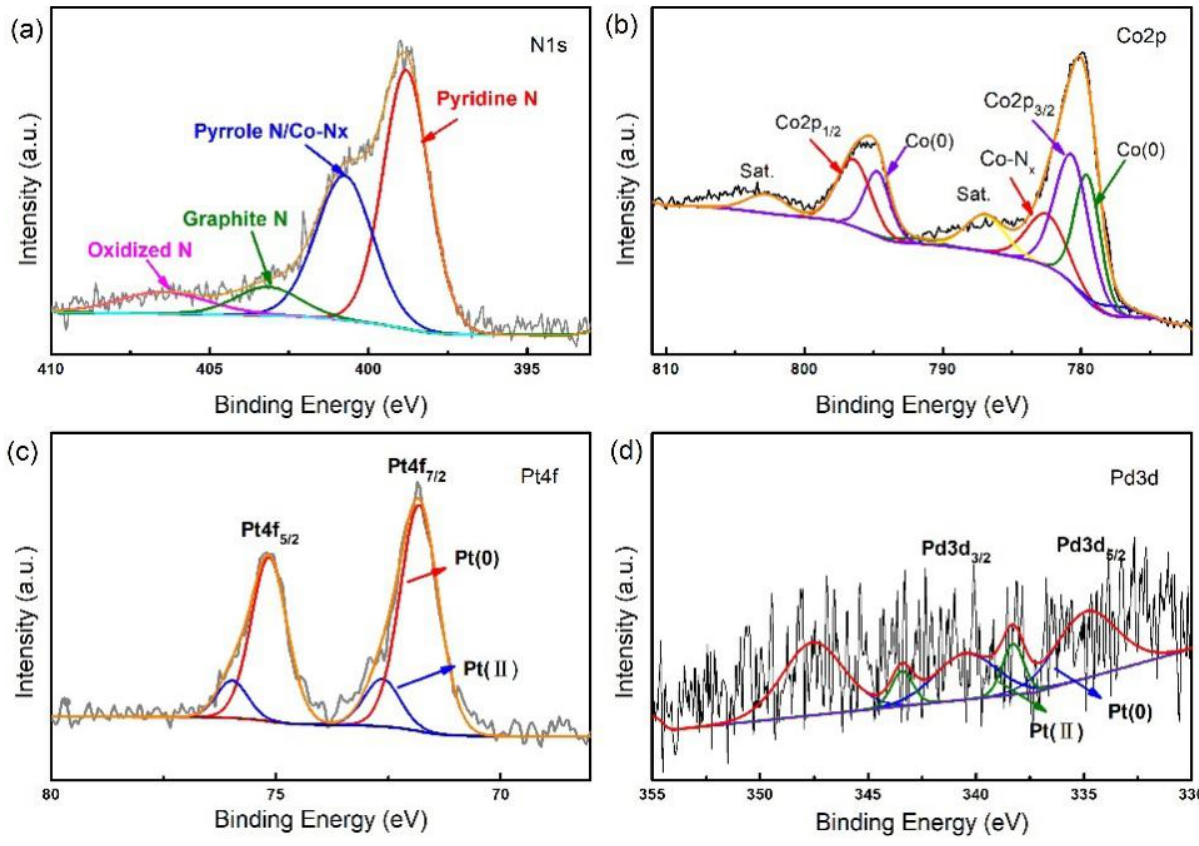
Figure 3. N1s XPS spectra ( a ), Co2p XPS spectra ( b ), Pt4f XPS spectra ( c ), and Pd3d XPS spectra( d ) of Pt/Pd/Co-N-C.